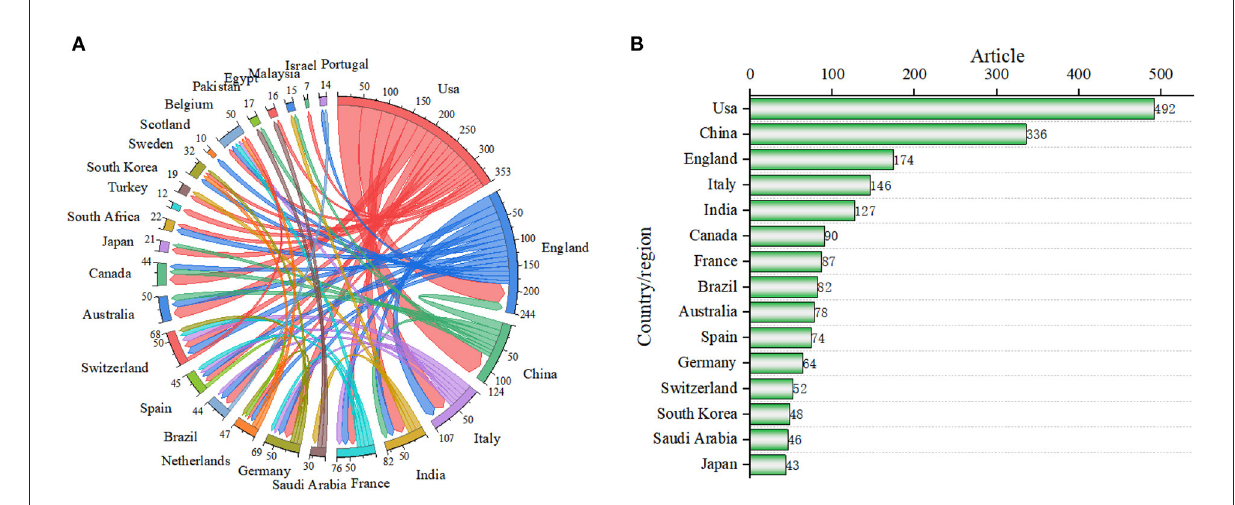
FIGURE3 (A) Mapping knowledge domains of co-authoring countries/regions. (B) Top 15 countries in the number of articles published.